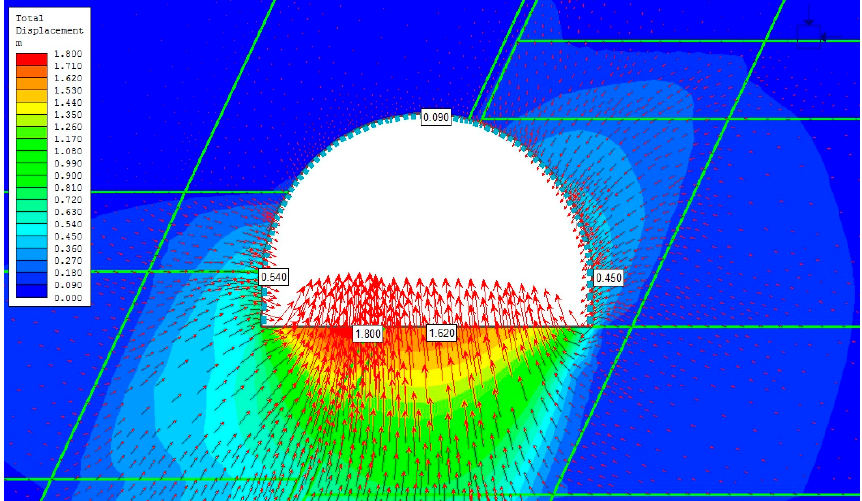
Figure 15. Model no 3—Maingate D-2 in the fault zone—map of total displacement. Figure 15. Model no. 3—Maingate D-2 in the fault zone—map of total